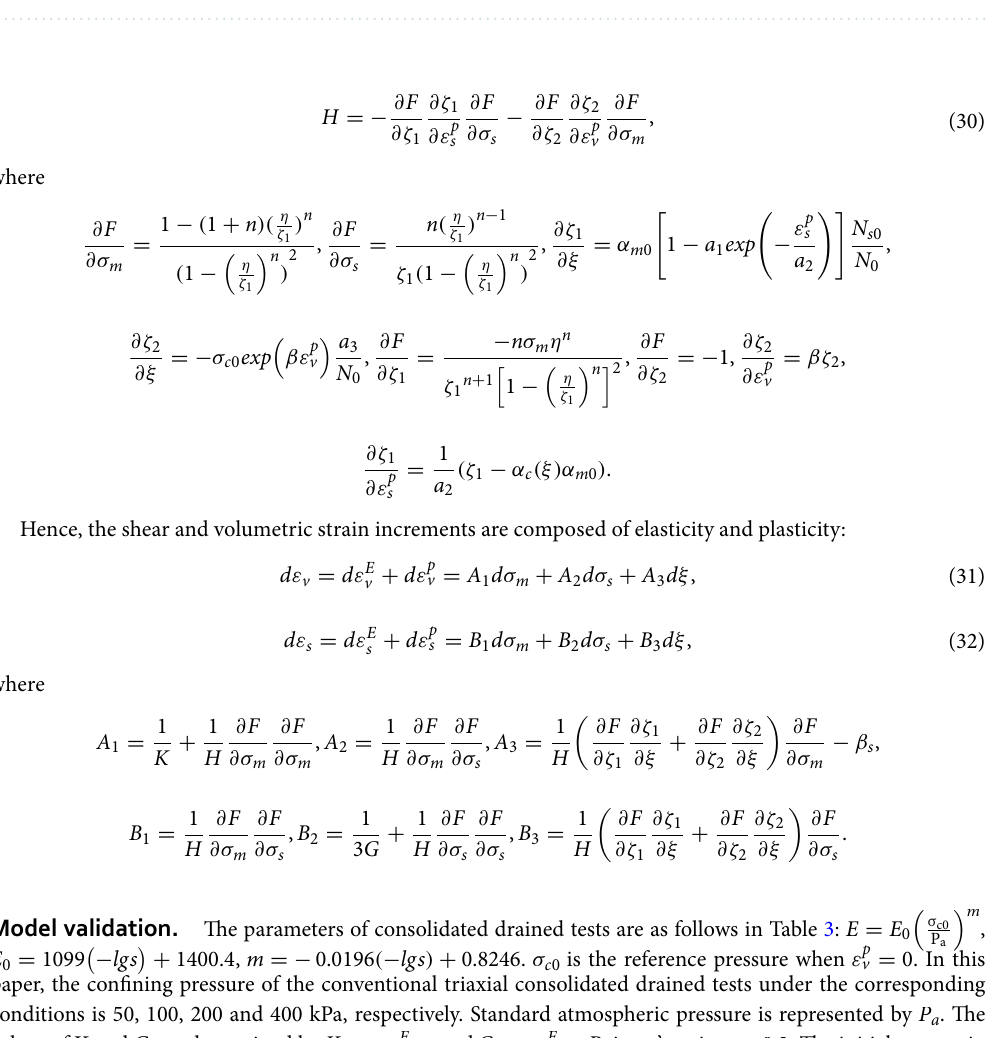
Table 3. The parameters under the different pH